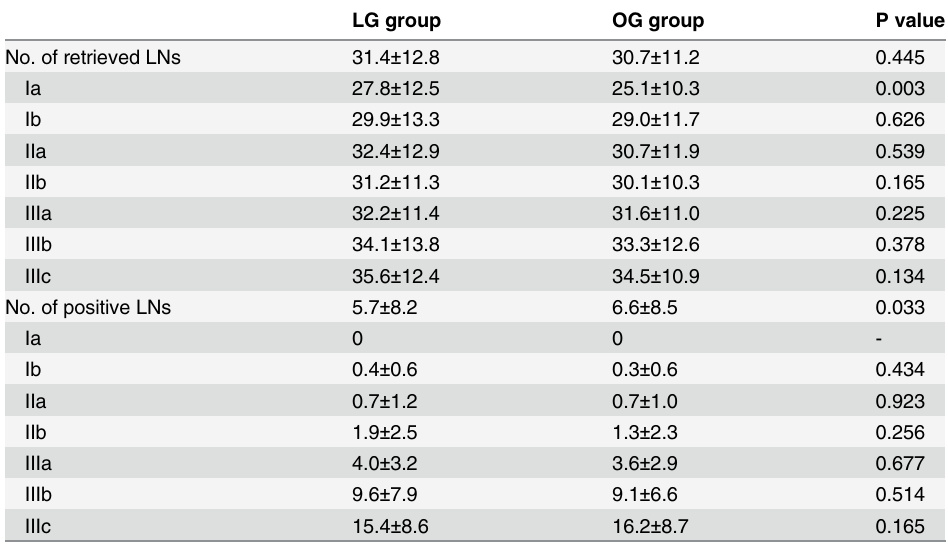
Table 3. Lymph node retrieval for LG and OG